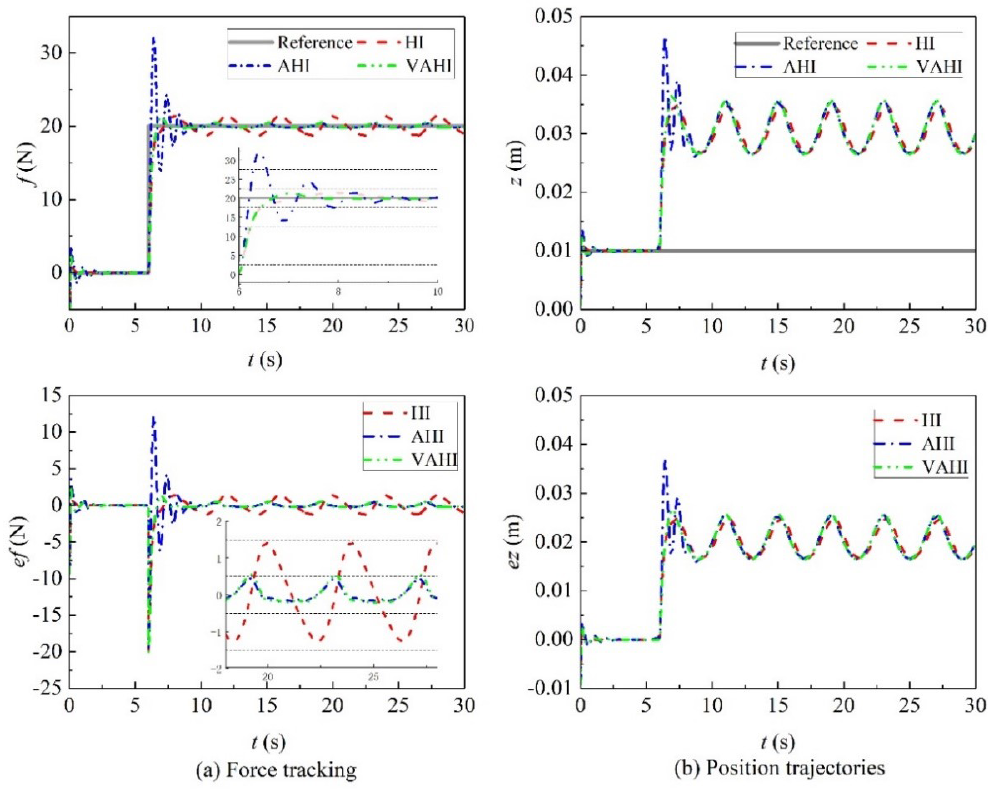
Figure 5. Tracking of the constant force with HI, AHI, and VAHI control schemes in the flat surface.